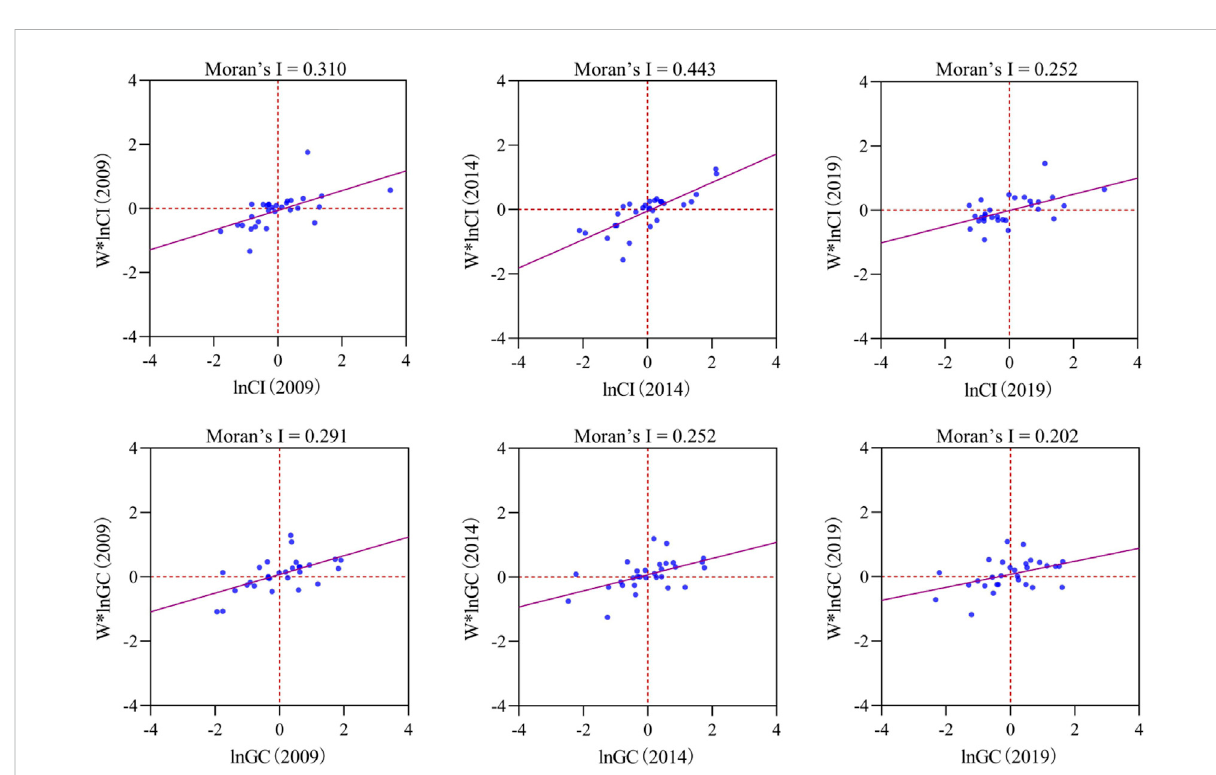
FIGURE 3 Moran scatter plot of agricultural carbon intensity and green credit in 2009, 2014, and